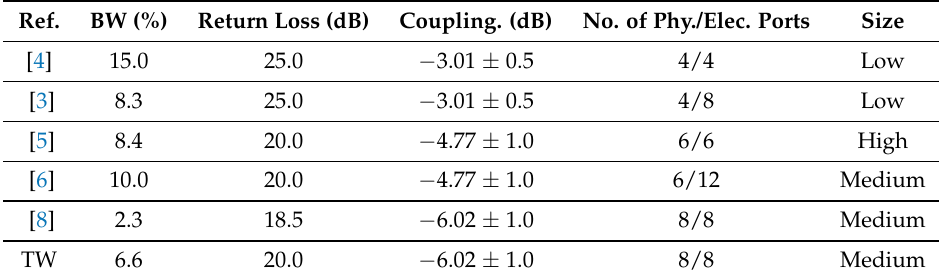
Table 2. Comparison of different types of aperture-type couplers having diverse physical and electrical ports. BW, Bandwidth; Phy, Physical; Elec., Electric; TW, This Work. Ref. BW (%) Return Loss (dB) Coupling.